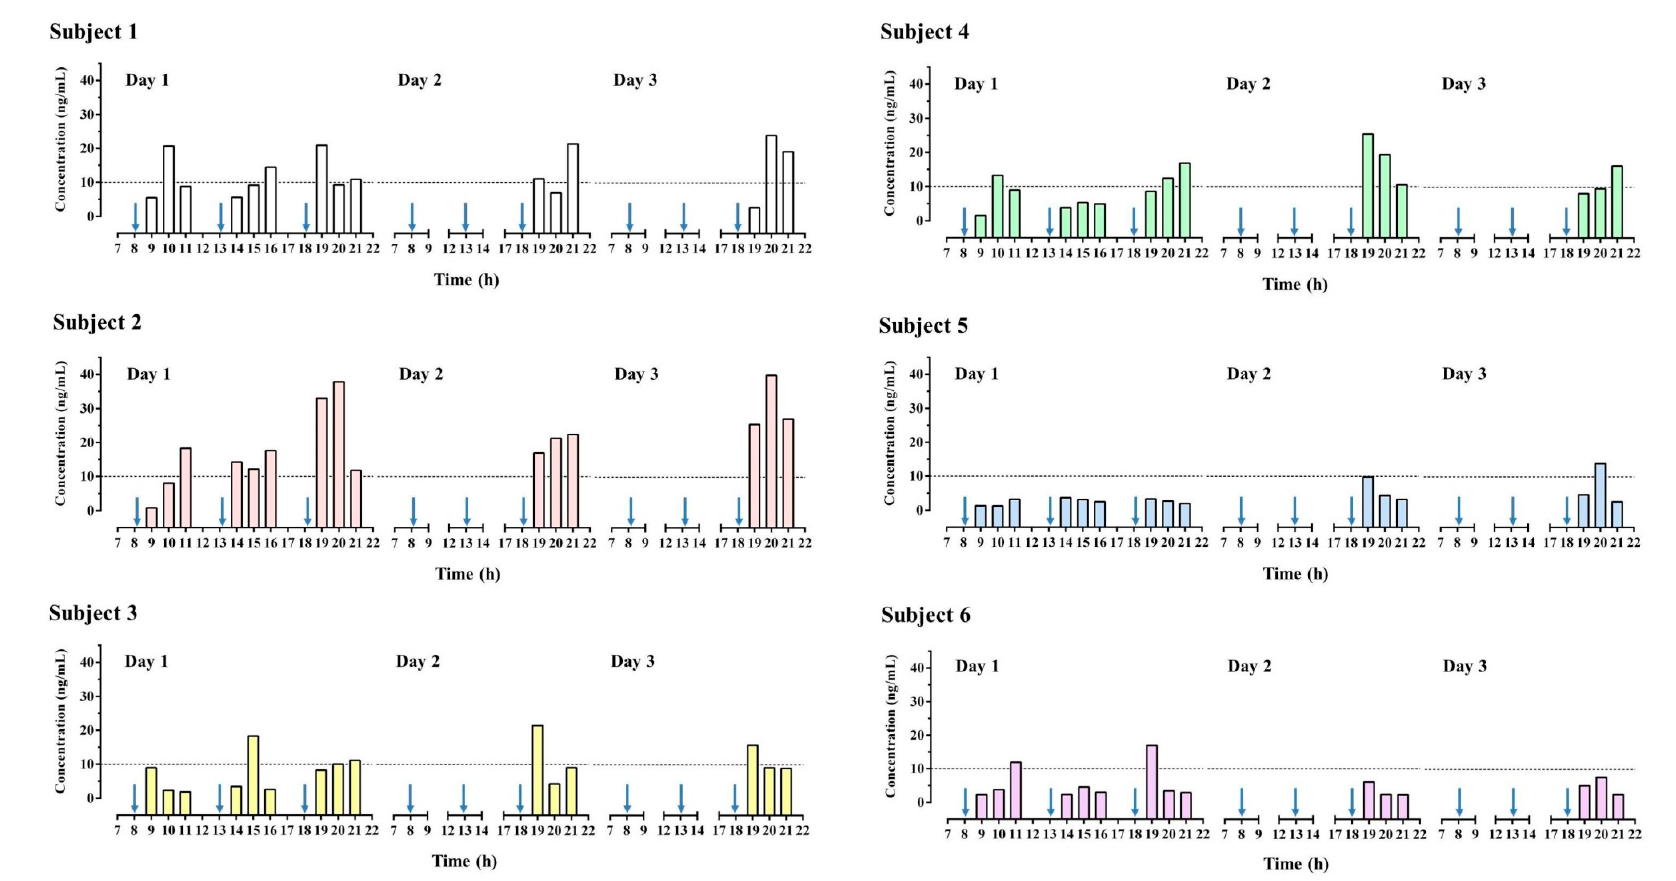
Figure 4. Urinary concentration-time profile of higenamine in participants received multiple administration of consuming herbal extract product (HEP-3). Arrow indicated the time of HEP-3 administration.